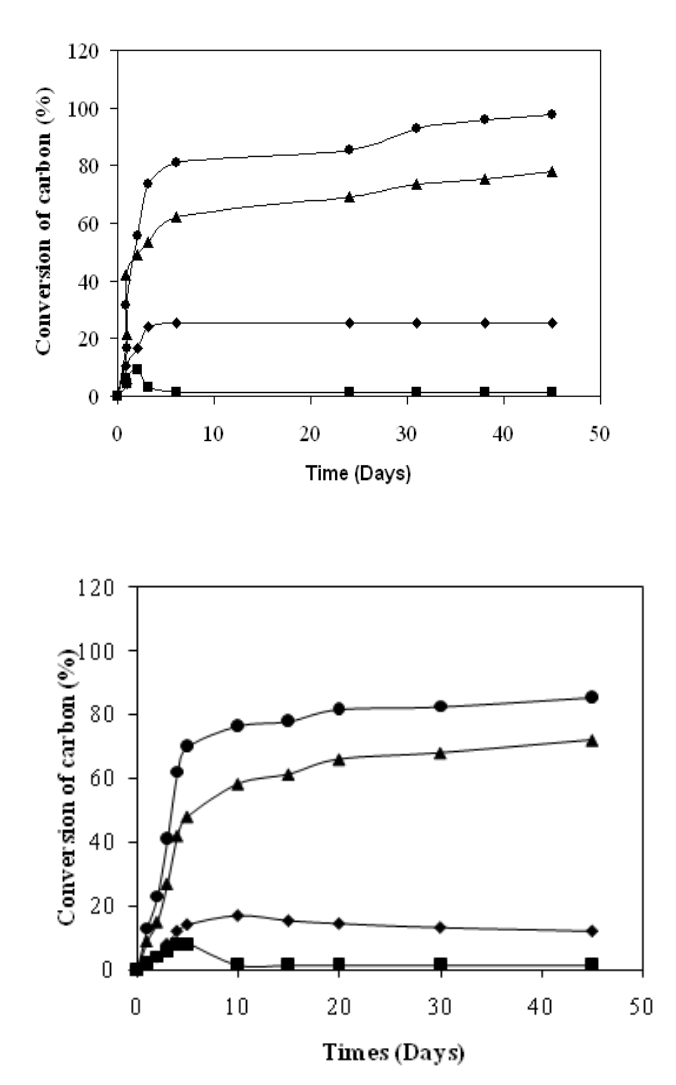
Figure 4. A. Carbon balance during the co-extruded film degradation in